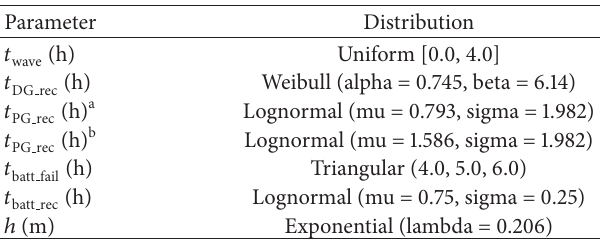
Table 3: Probability distribution functions for sets of uncertainty